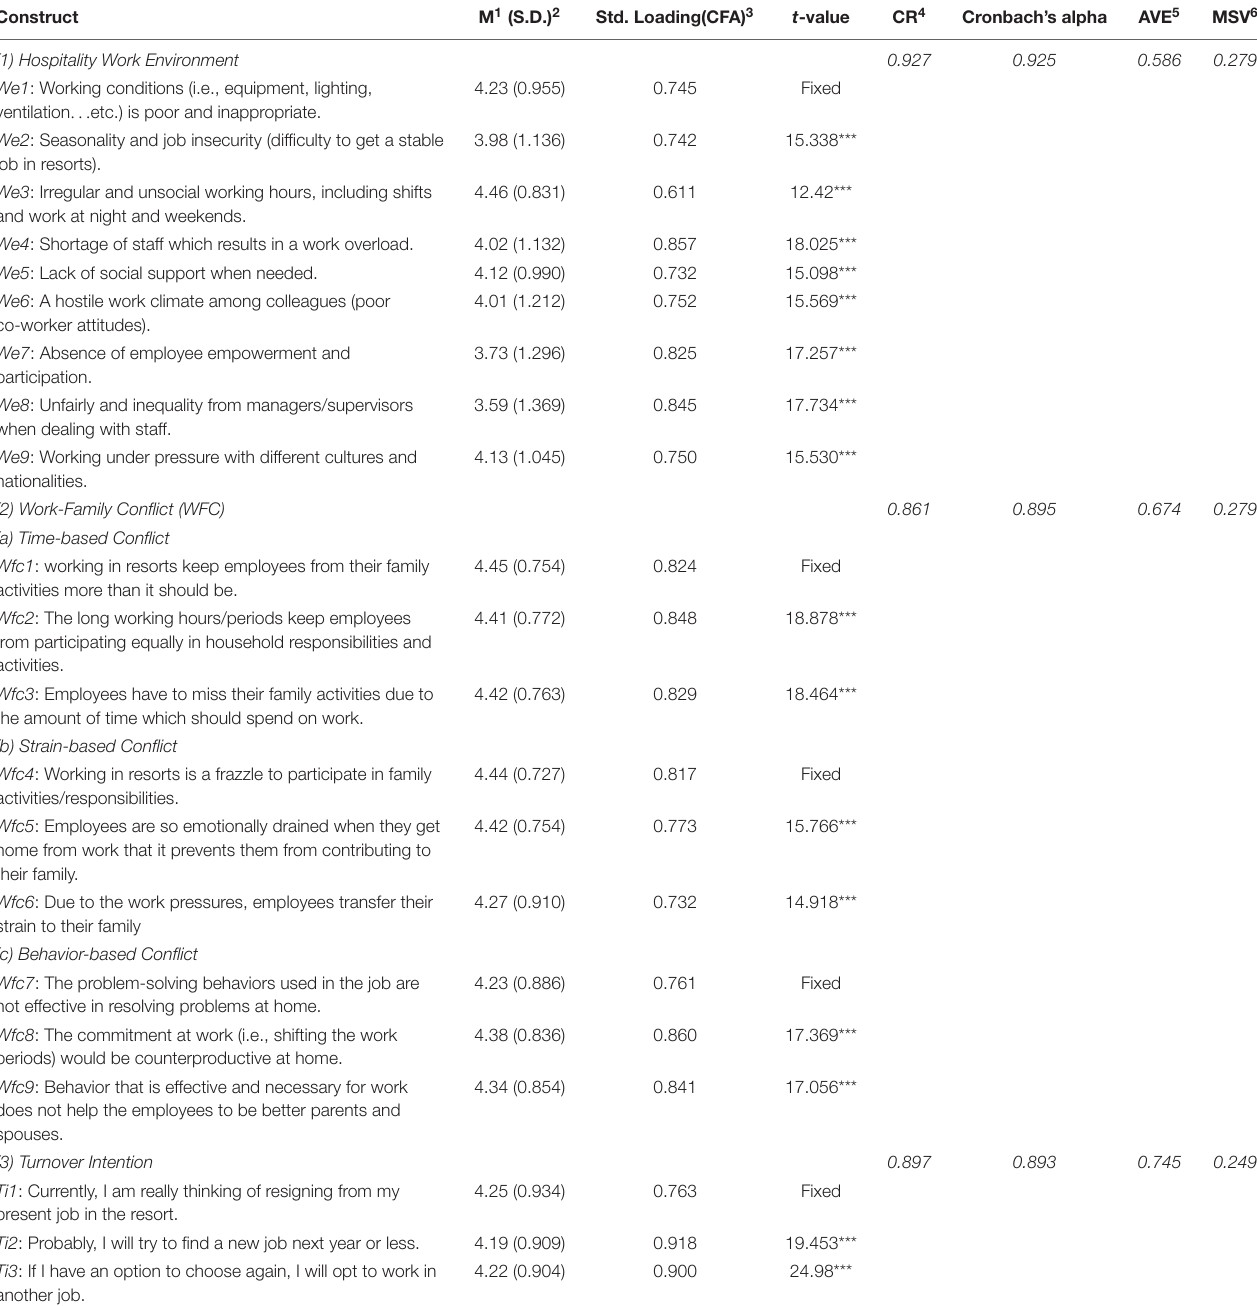
TABLE 1 | Descriptive statistics, reliability, and confirmatory factor analysis properties.